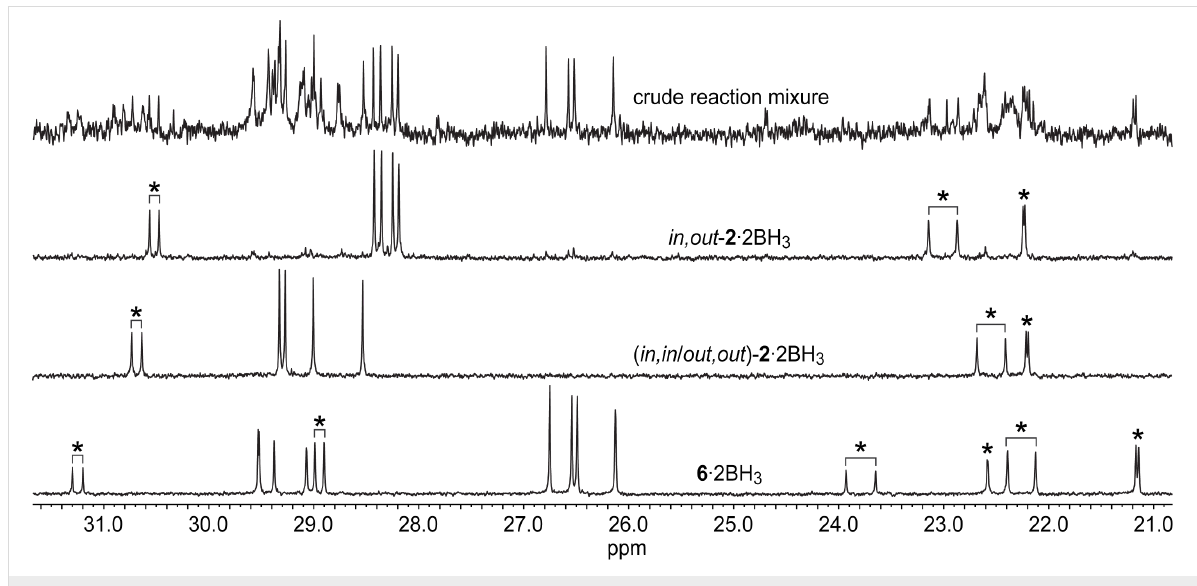
Figure 1: The 13 C{ 1 H} NMR spectra (CDCl 3 , 100 MHz) of in , out - 2 ·2BH 3 , ( in,in / out , out )- 2 ·2BH 3 , 6 ·2BH 3 , and the crude reaction mixture after hydrogenation from Scheme 5 (top); doublets are marked with an